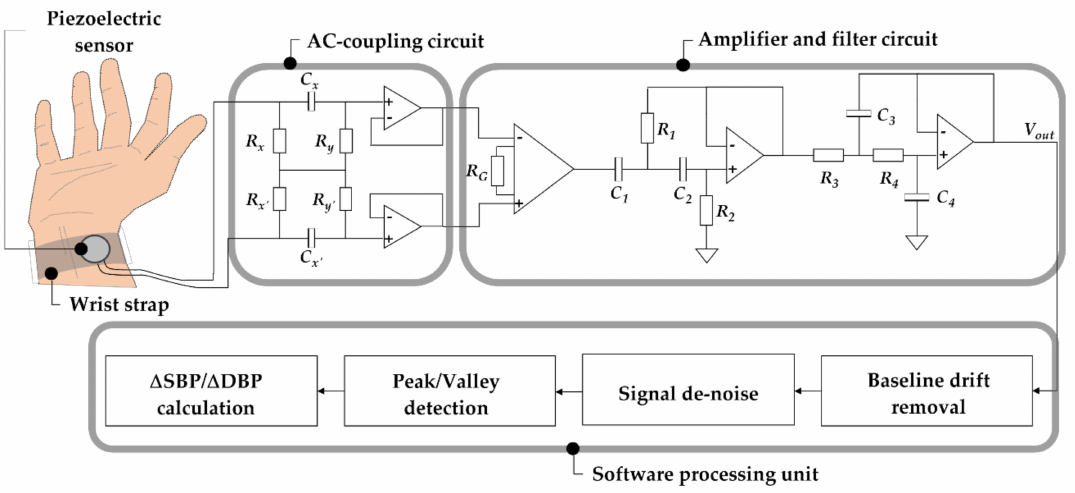
Figure 3. Schematic of the overall system.